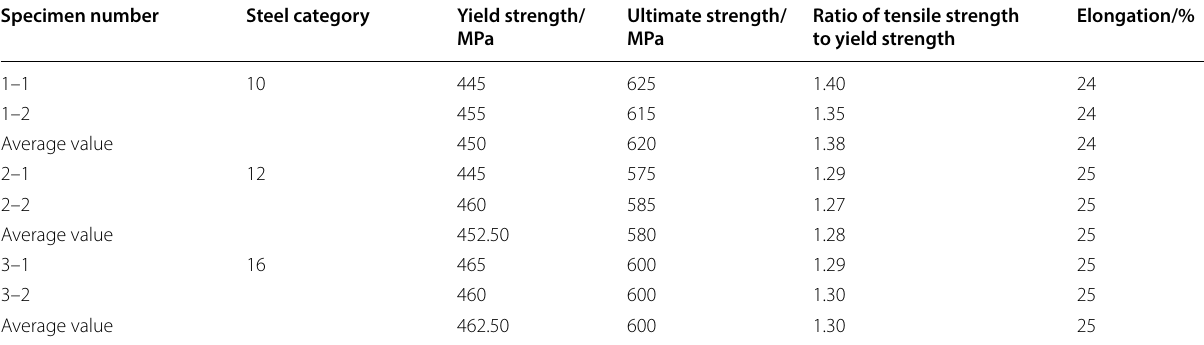
Table 3 Mechanical property of steel.